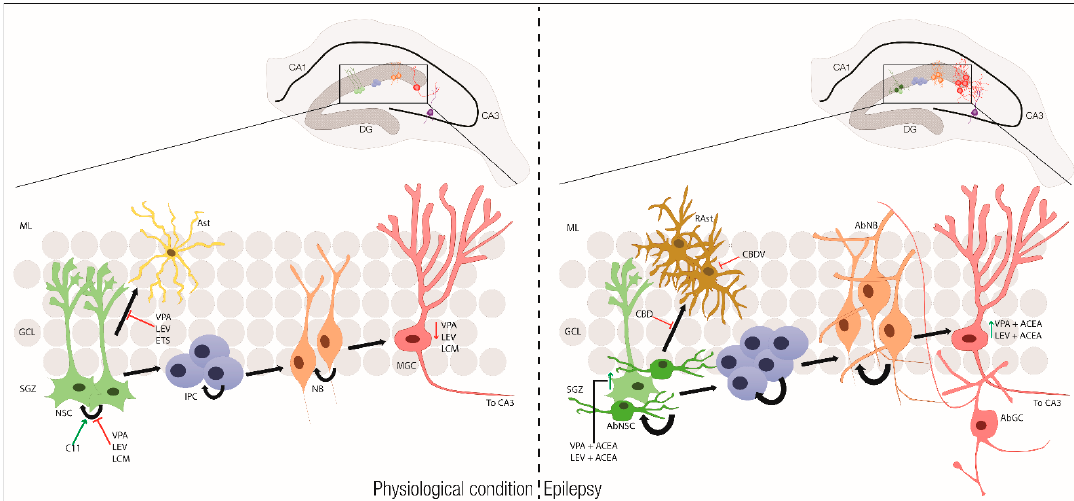
Figure 5. The effect of antiepileptic drugs (AEDs) and cannabinoids in physiological conditions and epilepsy. In physiological conditions (left), SGZ NSCs divide and ultimately differentiate into mature granule cells (MGC) that are able to make functional connections with the CA3 region of the hippocampus. NSCs can also generate astrocytes (Ast). AEDs, such as VPA, LEV, and LCM, decrease NSC proliferation and diminishes the maturation of MGC. Differentiation into astrocytes is blocked by VPA, LEV, and ETS. In epilepsy (right), NSCs fails to divide correctly and generate abnormal NSCs (AbNSC). On the other way, SGZ NSCs can ultimately convert into reactive astrocytes (Rast). The uncontrolled and excessive production of IPCs will translate into defective aberrant neuroblasts (AbNB) and new aberrant neurons (AbGC) with altered morphological and electrophysiological properties. The proliferative capacity of normal NSCs is compromised, leading to a depletion of the NSC population, resulting in diminished neurogenesis overtime. ACEA, when combined with VPA and LEV, restores to normal levels, NSC proliferation and promotes maturation of MGC. CBD inhibits proliferation and differentiation of Rasts, while CBDV decreases their reactivity. ACEA = arachidonyl- 2 ′ -chloroethylamide; C11 = hybrid antiepileptic compound; CBD = cannabidiol; CBDV = cannabidivarin; ETS = ethosuximide; IPC = Intermediate progenitor cells; LCM = lacosamide; LEV = levetiracetam; MGC = Mature Granule cell; ML = Molecular layer; NB = Neuroblast; NSCs = Neural Stem Cells; SGZ = Subgranular Zone; VPA = valproic acid.